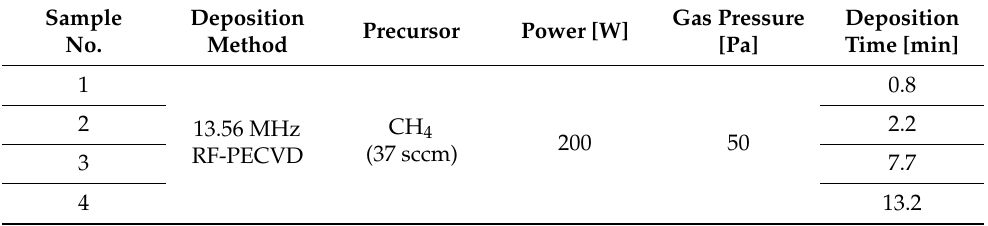
Table 1. Polymer-like carbon (PLC) film deposition